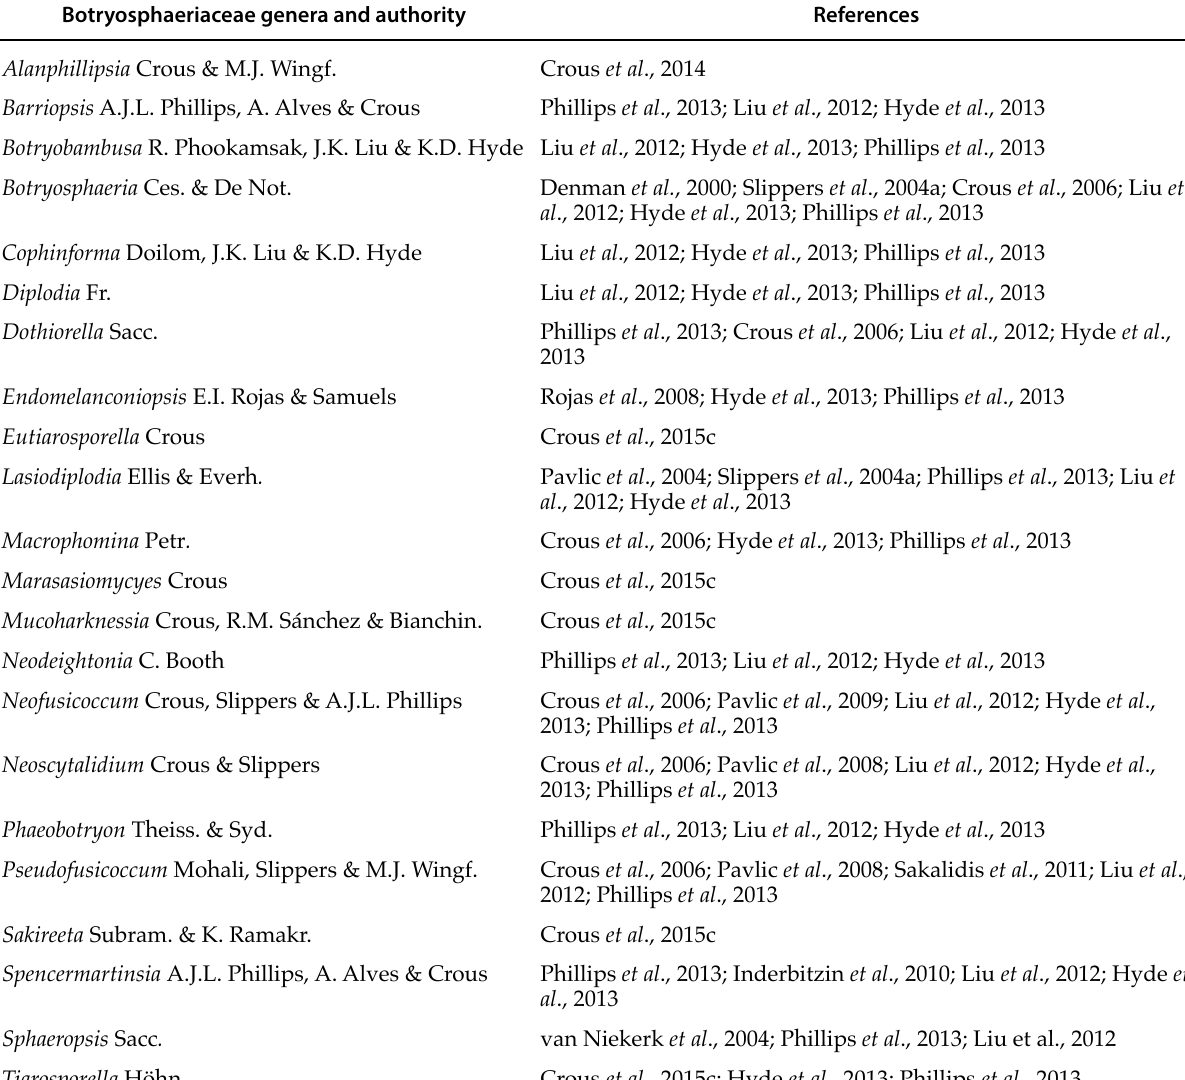
Table 1. Currently accepted genera of